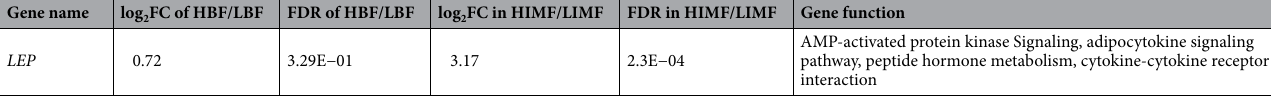
Table 2. Potential key candidate genes identified from the transcriptome. LBF low backfat thickness, HBF high backfat thickness, HIMF high intramuscular fat, LIMF low intramuscular fat, log 2 FC log 2 fold change, FDR false discovery rate.